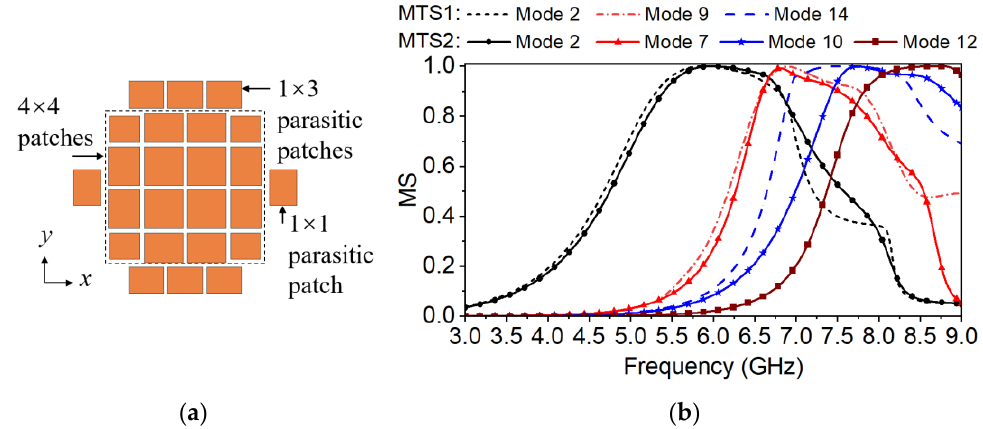
Figure 4. Configuration and the MSs of the modified metasurface with parasitic patches (MTS2). ( a ) Metasurface topology of MTS2. ( b ) The MSs of MTS1 and MTS2. The MSs of MTS2 are calculated and the selected four modes — Modes 2, 7, 10, 12 —